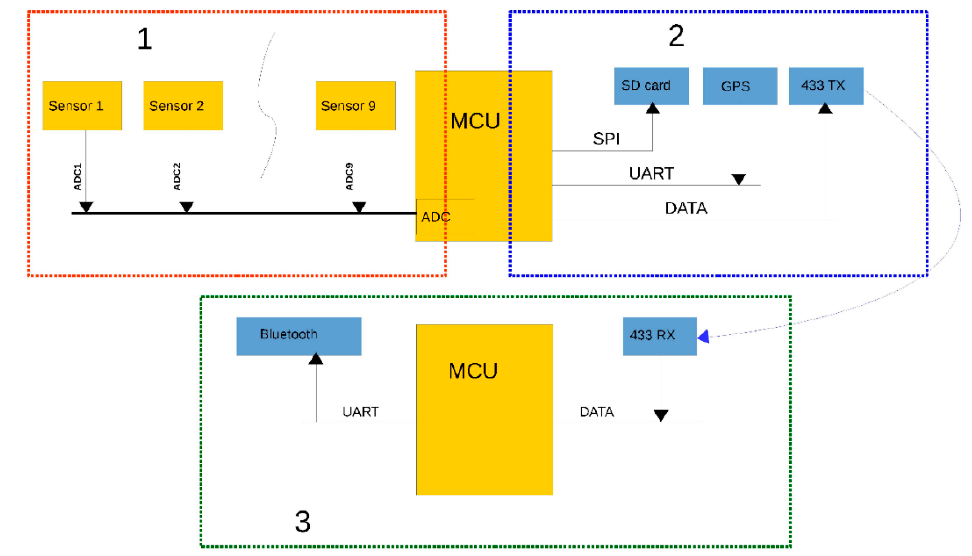
Figure 2. Measurement system diagram measuring (1) the sensor module, (2) the data module, and (3) the receiver module.